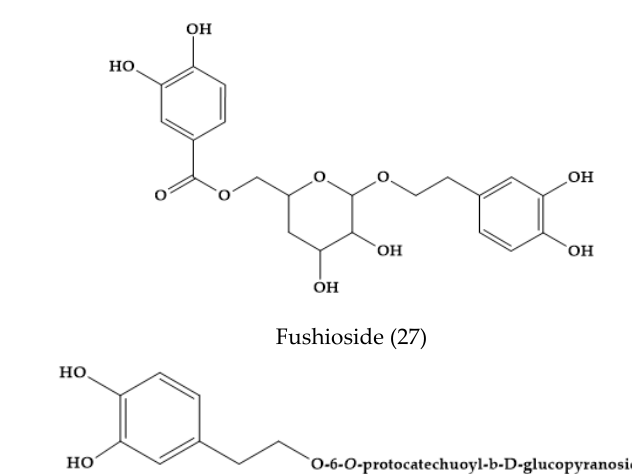
Figure 4. Phytochemicals from Veronica linariifolia essential oil.